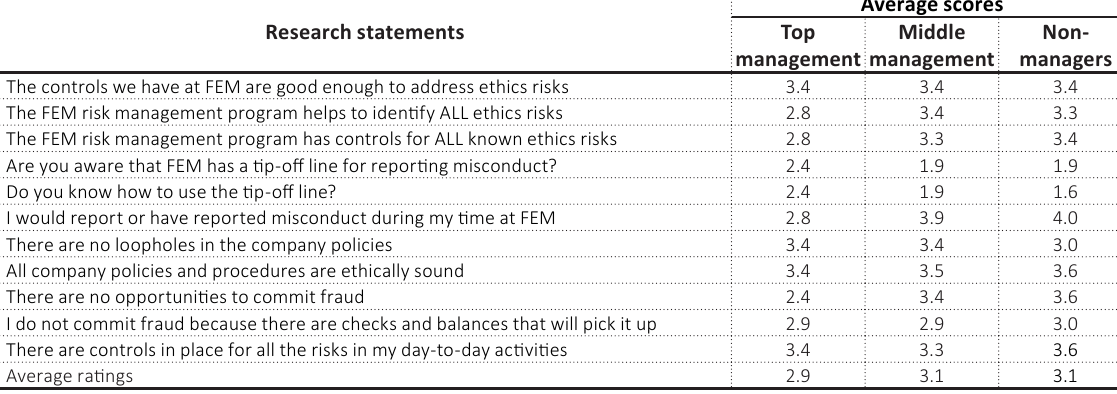
Table 3. Perception of ERM controls